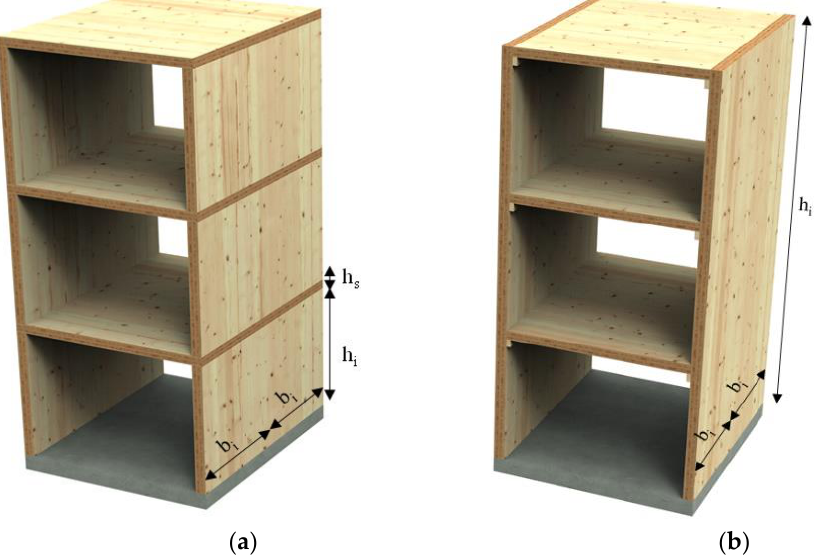
Figure 1. Platform-type ( a ) and balloon-type ( b ) construction (schematic produced by Andrea Roncari (UBC student, reprinted with permission)). (UBC student, reprinted with